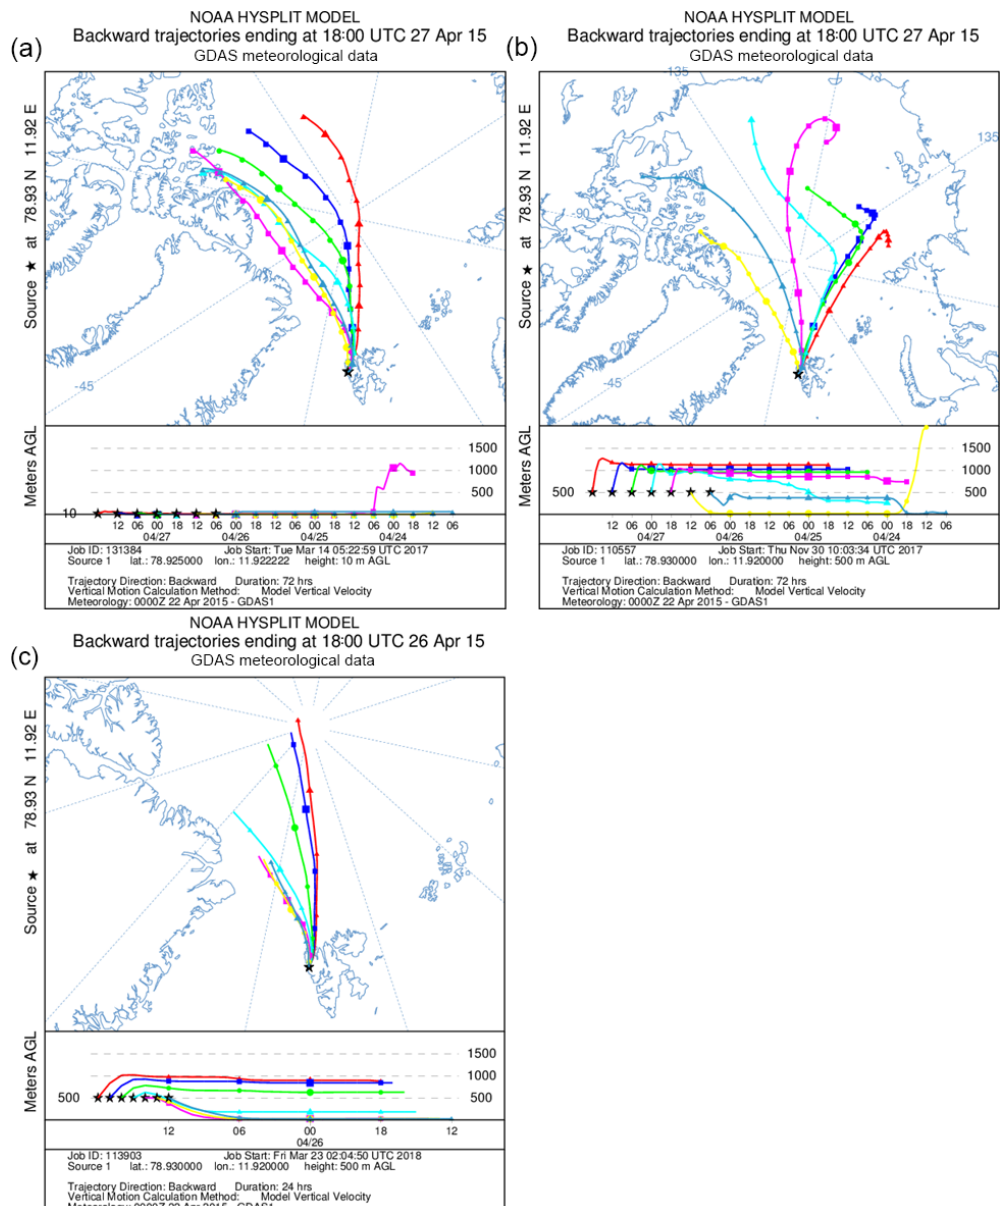
Figure 9. Back trajectory model of air masses arriving at Ny-Ålesund ending on 27 April at 18:00UTC at 10 (a) and 500ma.s.l. (b) . Every 6h a new trajectory starts, and each trajectory runs for 72h. Back trajectory model of air masses arriving at Ny-Ålesund ending on 26 April at 18:00UTC and 500ma.s.l. (c) . Every 6h a new trajectory